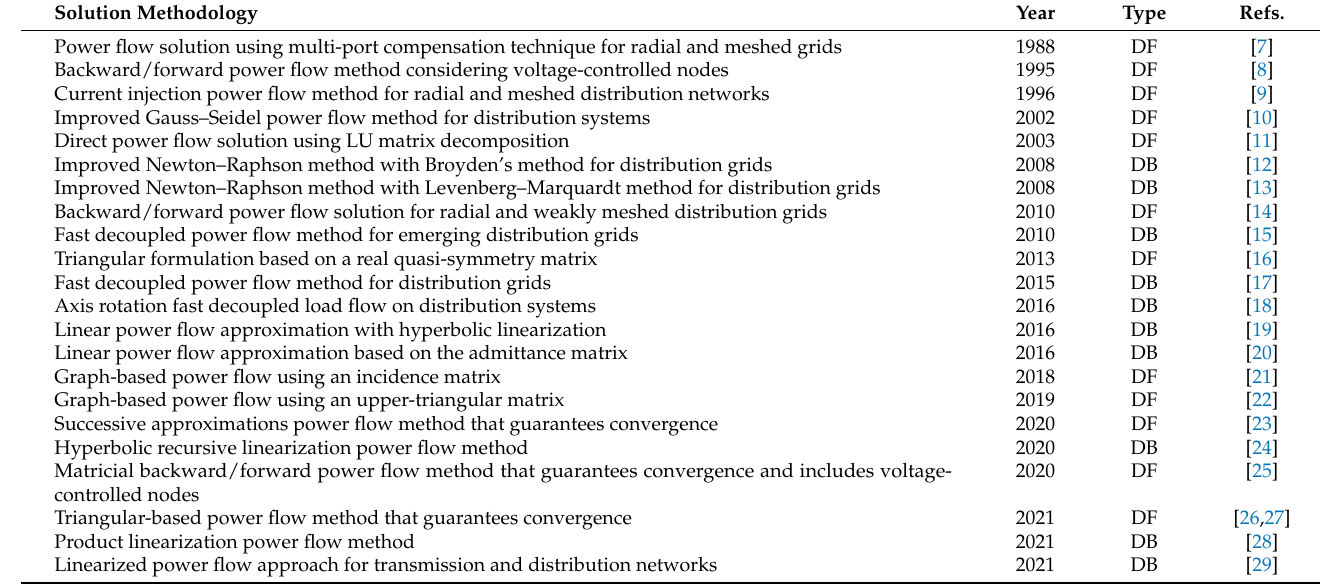
Table 1. Power flow methods for distribution networks.